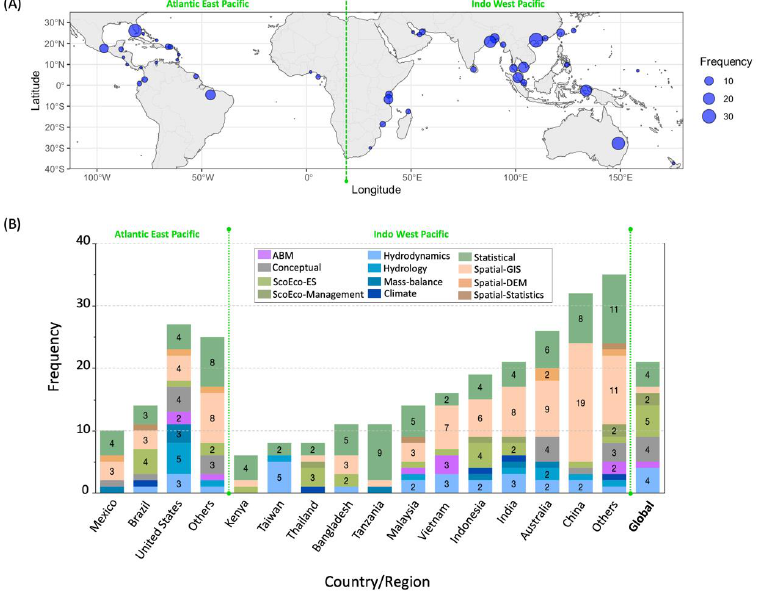
Figure 3. Number of publications (total) explicitly using mangrove models in R/R projects per biogeographical region ( A ) and country ( B ). The Atlantic–East Pacific (AEP) region includes countries in North, Central, and South America and West Africa; the Indo-West Pacific (IWP) region groups East Africa, the Middle East, Asia, and Oceania [46]. The “Global” category refers to publications focused on more than one single site or region; the “Others” category comprises countries with a low number of publications per model type/subtype. See Table S1 for further information about specific locations; notice that the bars with no number inside the bar in panel B equal 1.